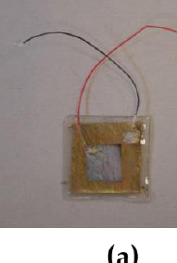
Figure 4. Photograph of PENGs devices made from ZnO NWs deposited on ( a ) Au/ZnO and ( b ) ITO/ZnO seed layer structures.